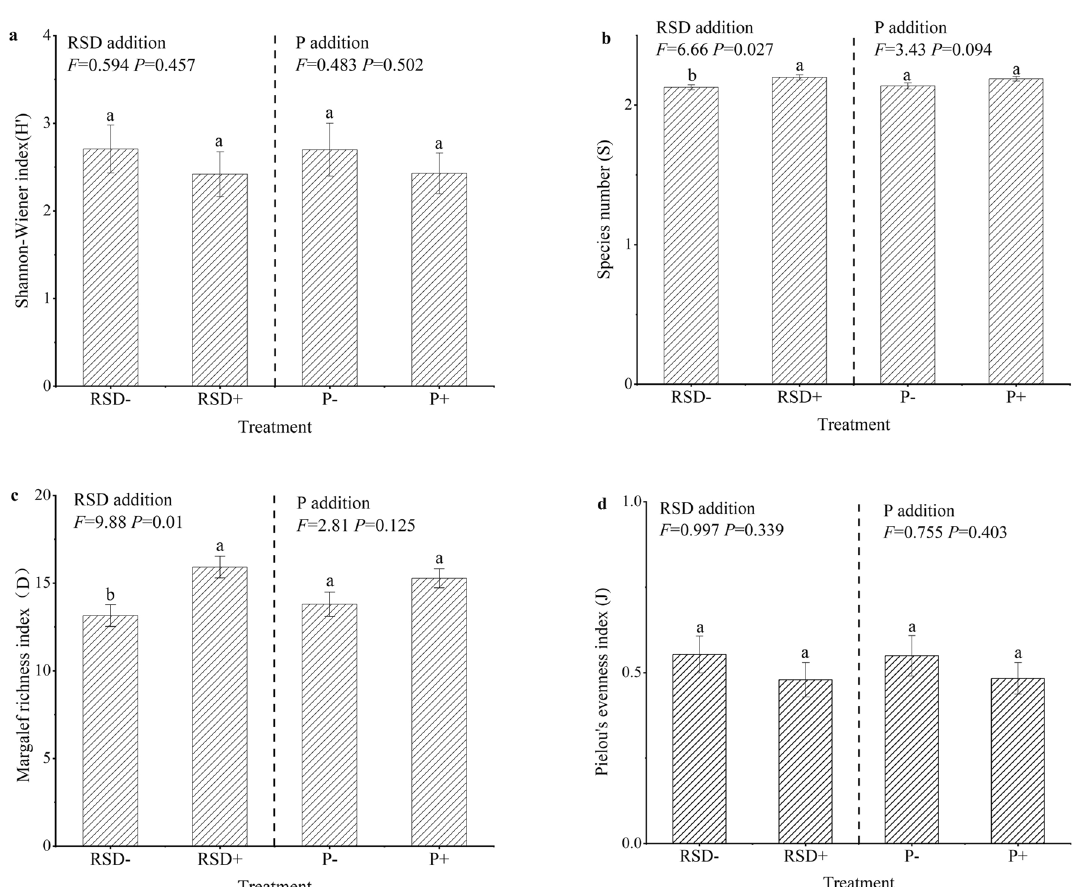
Figure 3. Effects of straw return (RSD) and phosphate fertilizer (P) on the Shannon–Wiener index (H ′ ) ( a ), species number (S) ( b ), Margalef richness index (D) ( c ) and Pielou evenness index (J) ( d ) of the soil faunal community (mean ± standard error). The species number (S) was transformed using log (x). Treatments with different letters (a and b) are significantly different (Two-way ANOVA, P < 0.05; n = 3). RSD+ (the treatments with crop straw return): RSDN, RSDNP and RSDNPK; RSD− (the treatments without crop straw return): N and NPK; P+ (the treatments with phosphorus fertilizer): NPK, RSDNP and RSDNPK; P− (the treatments without phosphorus fertilizer): N and